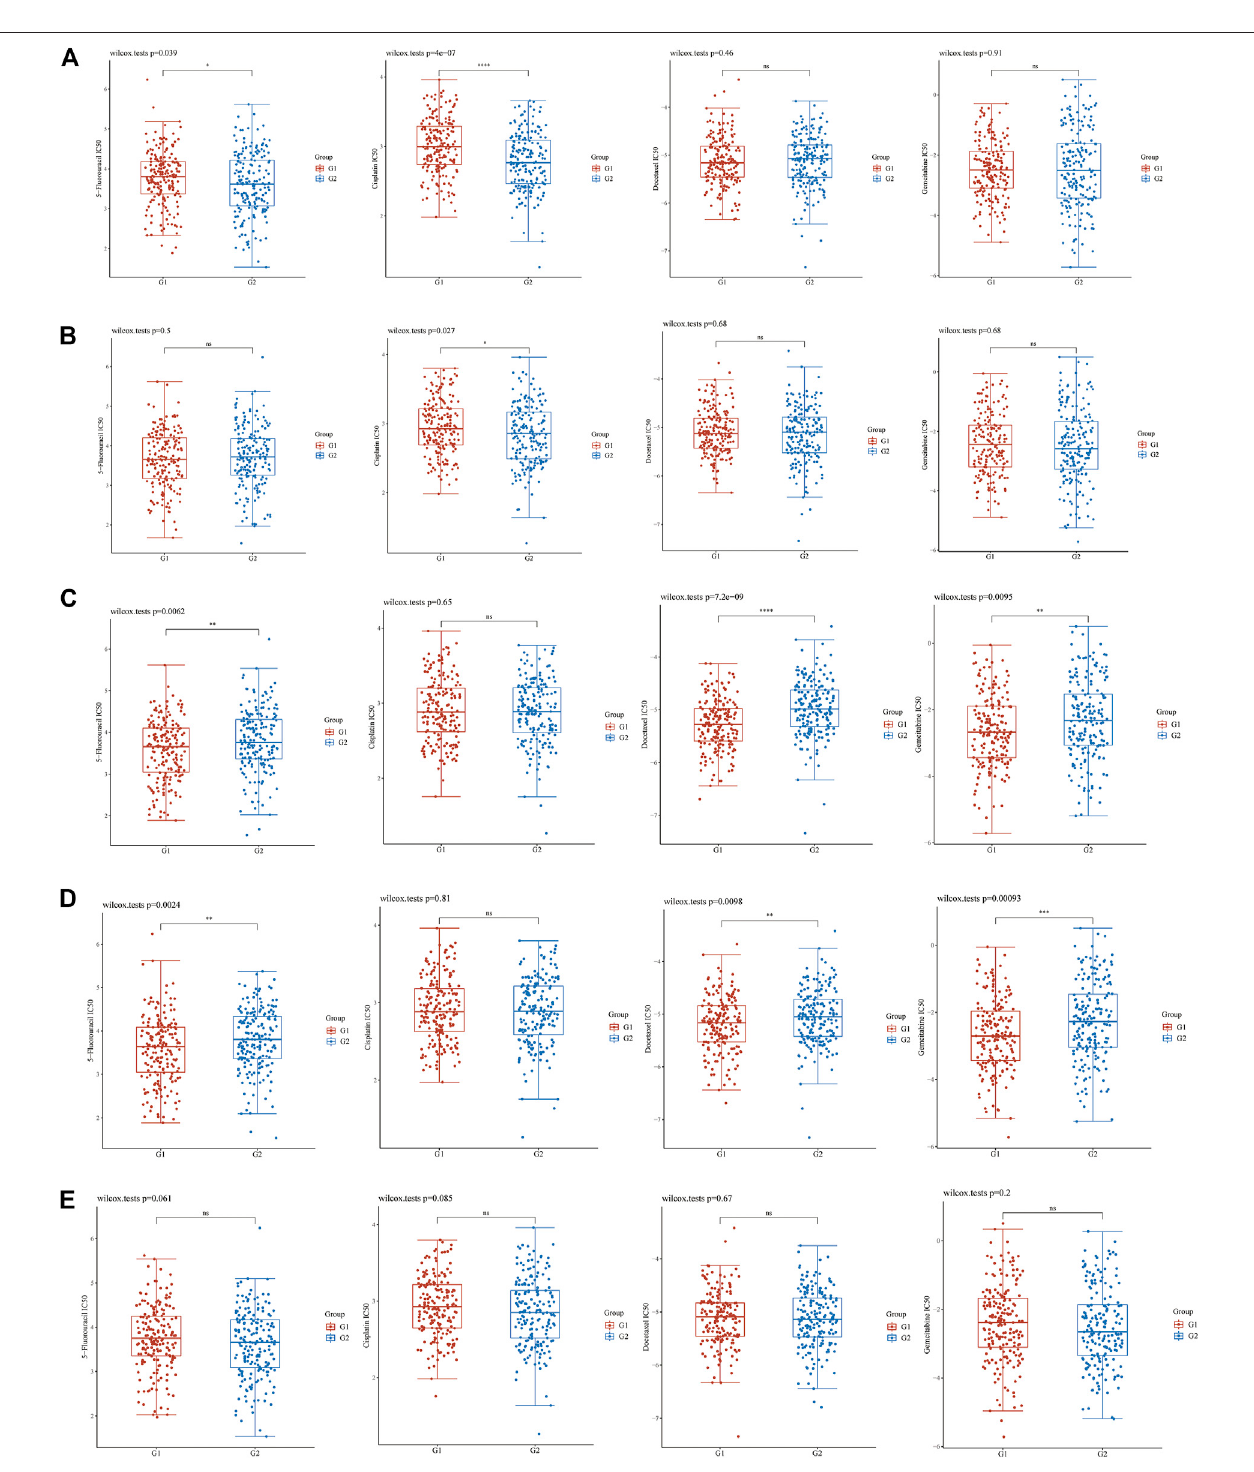
FIGURE 3 | IC 50 difference between high or low EFNA family genes expression of four chemotherapeutic drugs (5- fl uorouracil, cisplatin, docetaxel, and gemcitabine). (A) EFNA1 , (B) EFNA2 , (C) EFNA3 , (D) EFNA4 , and (E) EFNA5 . Thehorizontal axis representssamplesofdifferentgroups, theverticalaxis representsthe distribution of the IC 50 scores, the different colors represent different groups, and the upper left corner represents the signi fi cance of the P -value test method.